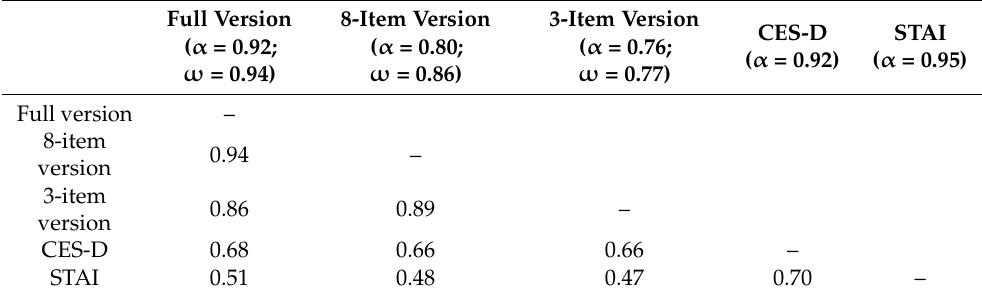
CES-D = Center for Epidemiological Studies Depression; STAI = State-Trait Anxiety Inventory. All p -values <